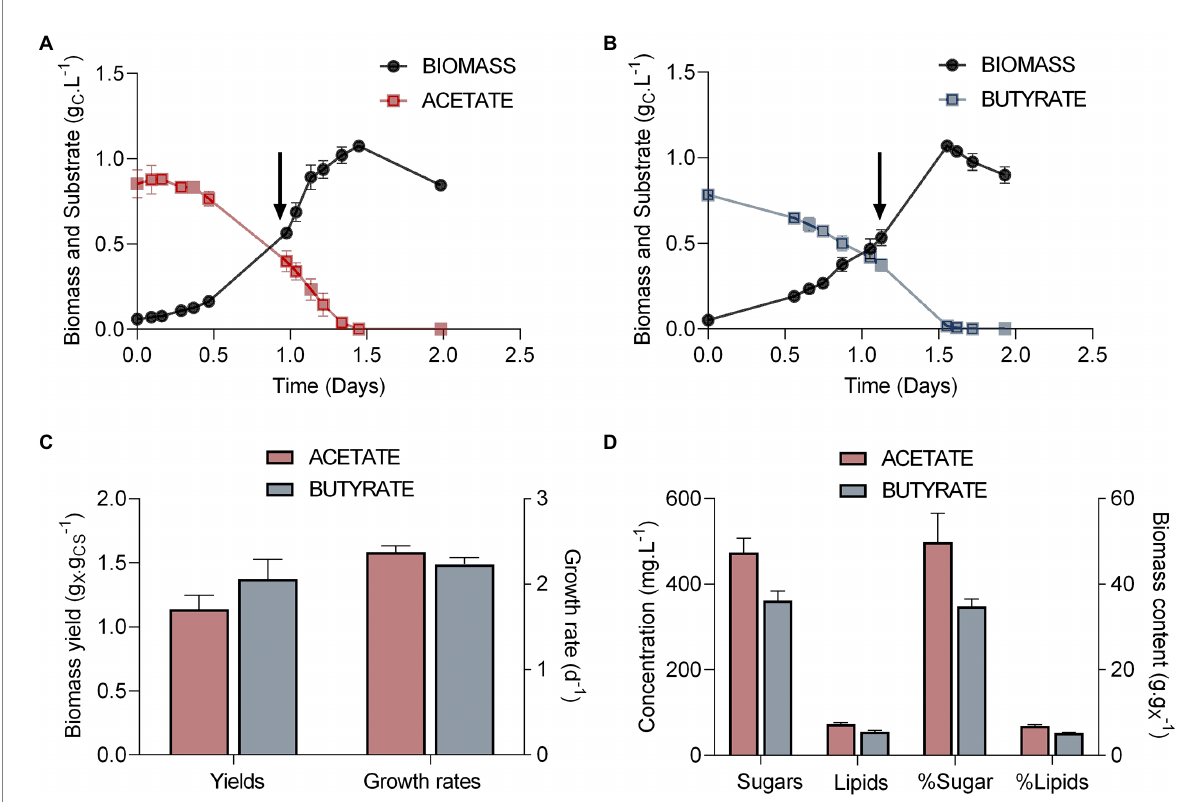
FIGURE 1 Parameters of the growth of P olytomella sp. on acetate and butyrate. (A, B) Growth curves (g X .L − 1 ) and substrate consumption (g CS .L − 1 ) in presence of 1 g CS .L − 1 acetate or butyrate, (C) biomass yields (g X .g CS − 1 ) and growth rates (d − 1 ) derived from these growth curves and (D) the concentrations of sugars and lipids are plotted on the left (g.L − 1 ) while their proportions to the total biomass are plotted on the right (g.g X − 1 ). Arrows indicate when biomass for further proteomics analysis was sampled. X, dry weight; CS, dissolved organic carbon. Error bars correspond to standard deviations based on 3 biological